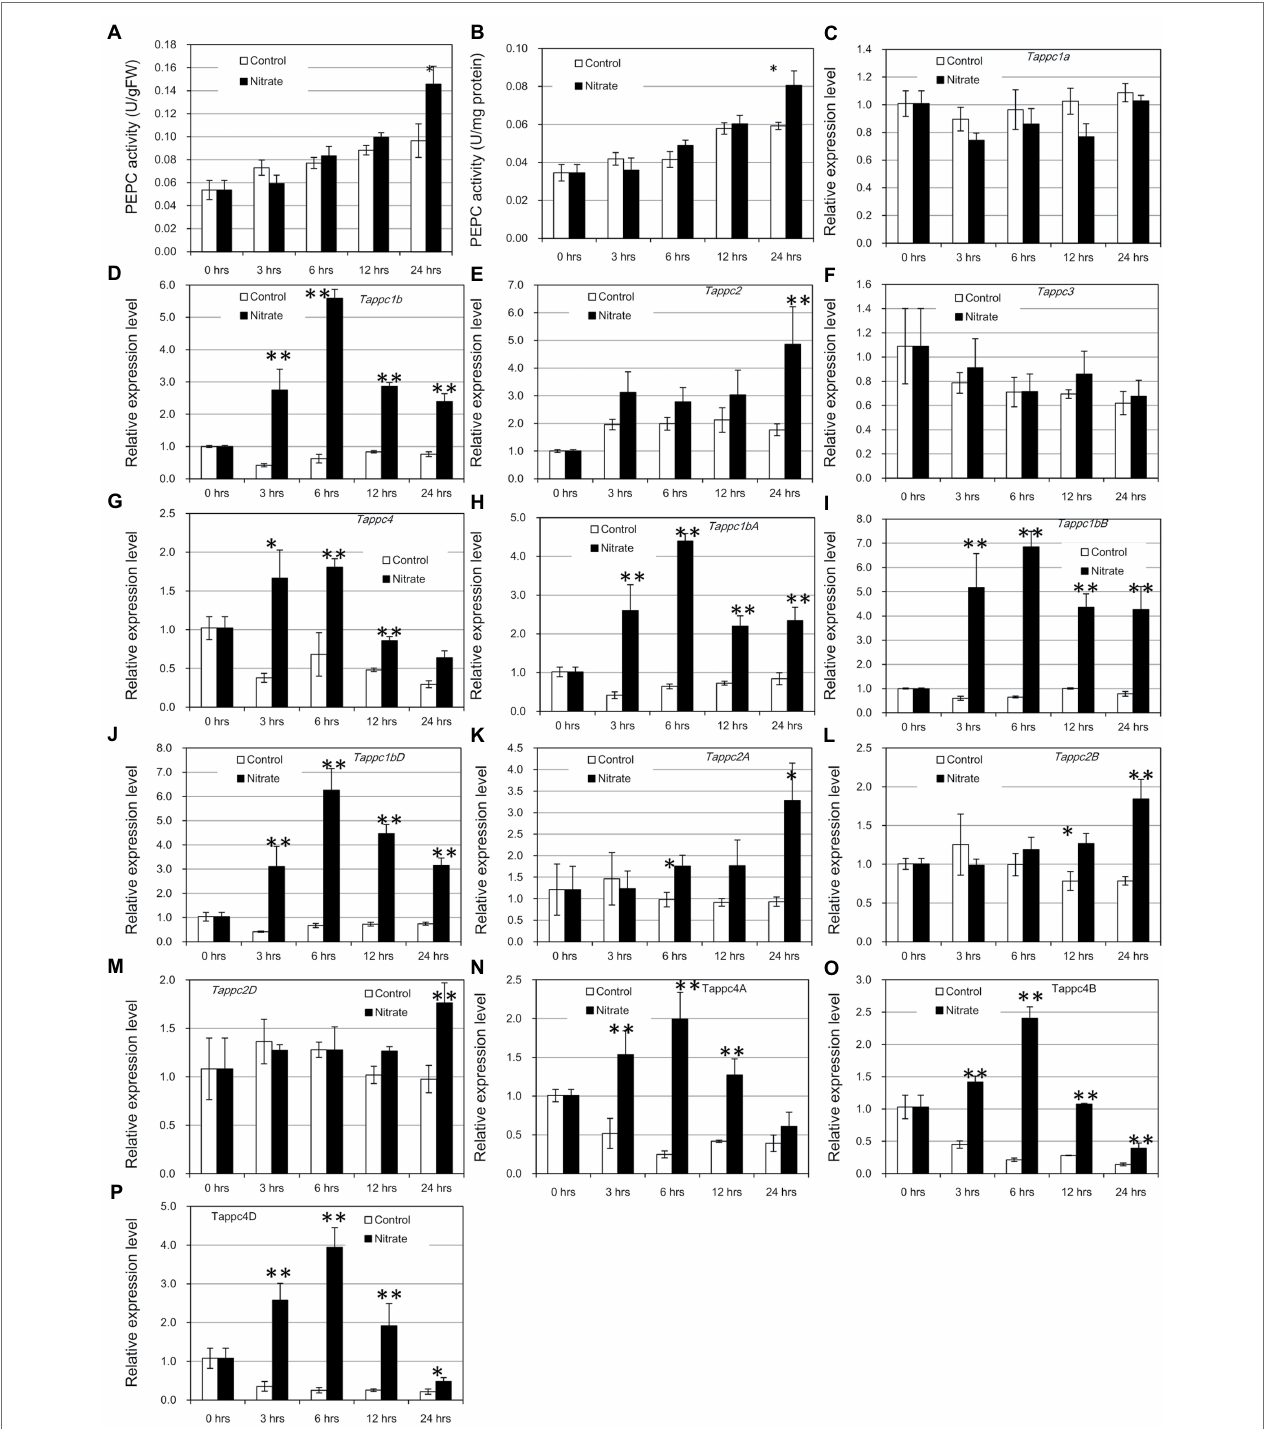
FIGURE 9 | Enzyme activity and gene expressions of PEPCs in response to nitrate. Error bars indicate SEs. Double and single asterisks indicate statistical significance at 5 and 10% level, respectively. (A) PEPC activity per g fresh weight, (B) PEPC activity per mg protein, (C–G) Relative expression levels of wheat PEPC isogene groups, and (H–P) Relative expression levels of Tappc1b , Tappc2 , and Tappc4 isogenes in the A, B, and D